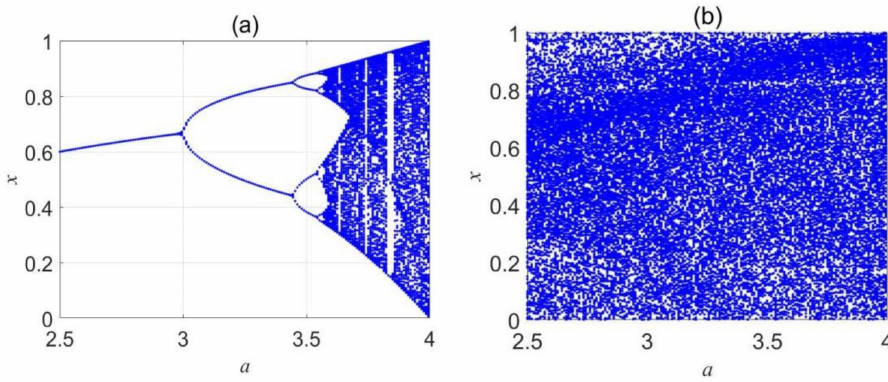
Figure 9. Bifurcation diagrams: ( a ) The original chaotic map; ( b ) The improved chaotic